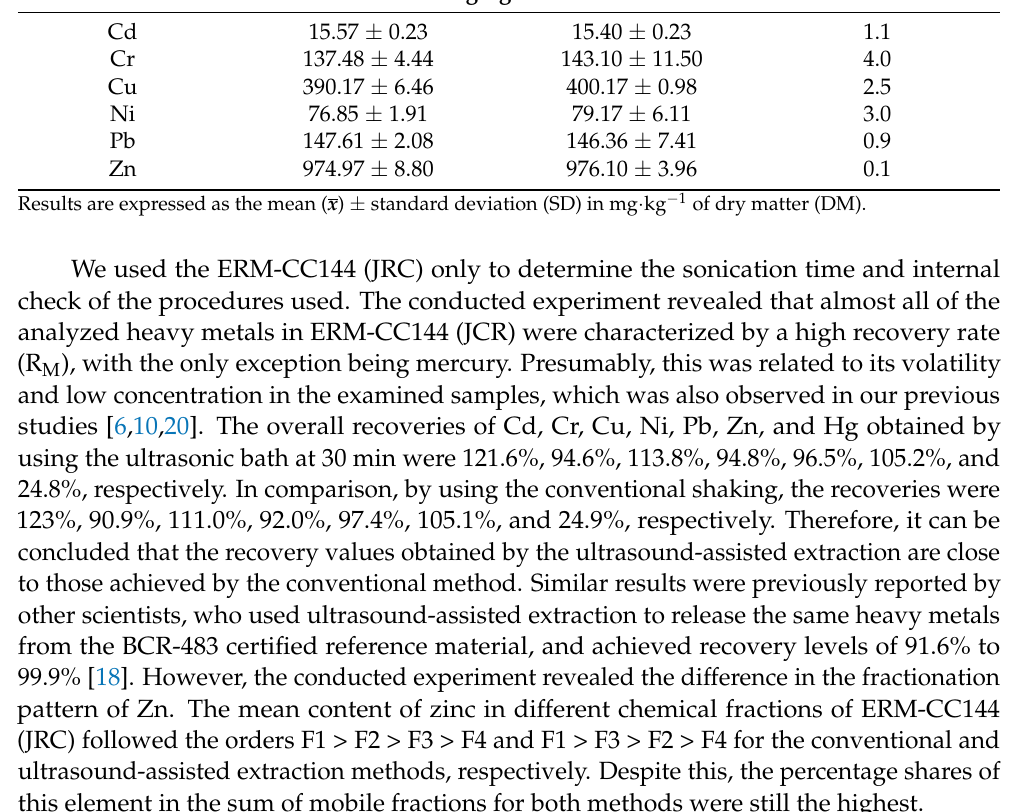
Table 5. The percentage differences between the content of heavy metals in the two methods of sequential extraction in ERM-CC144 (JCR). Sum of the 4 Chemical Fractions USEConventional Extraction HM